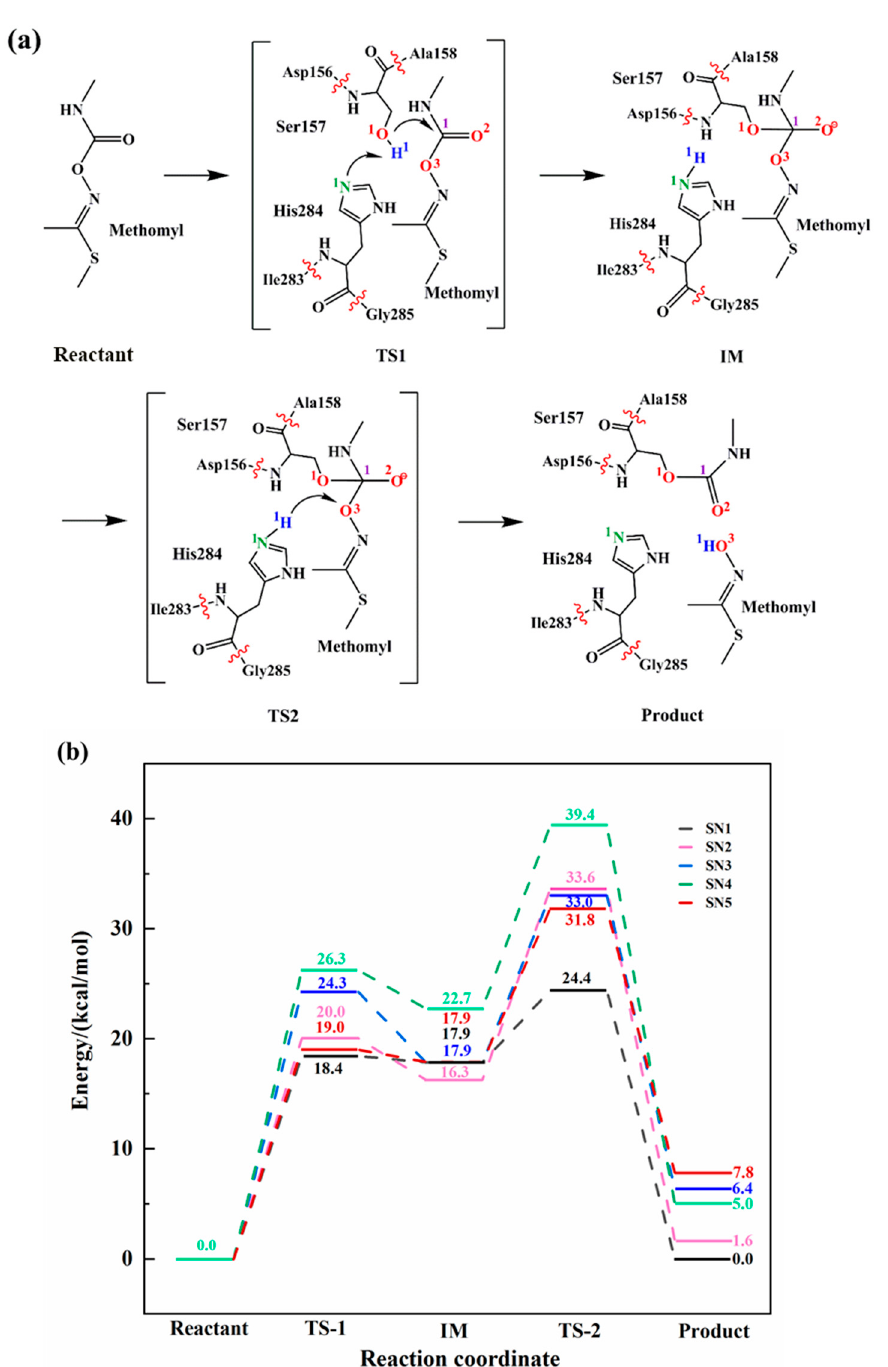
Figure 2. Reaction mechanism and energy profile of enzymatic catalysis reaction. ( a ) The proposed mechanism of the biodegradation of methomyl; ( b ) Energy profiles of 5 snapshots with different color.